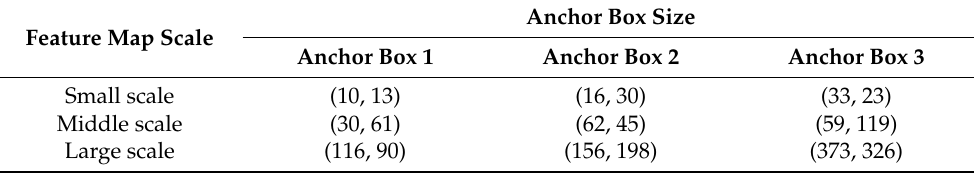
Table 1. Prior anchor box